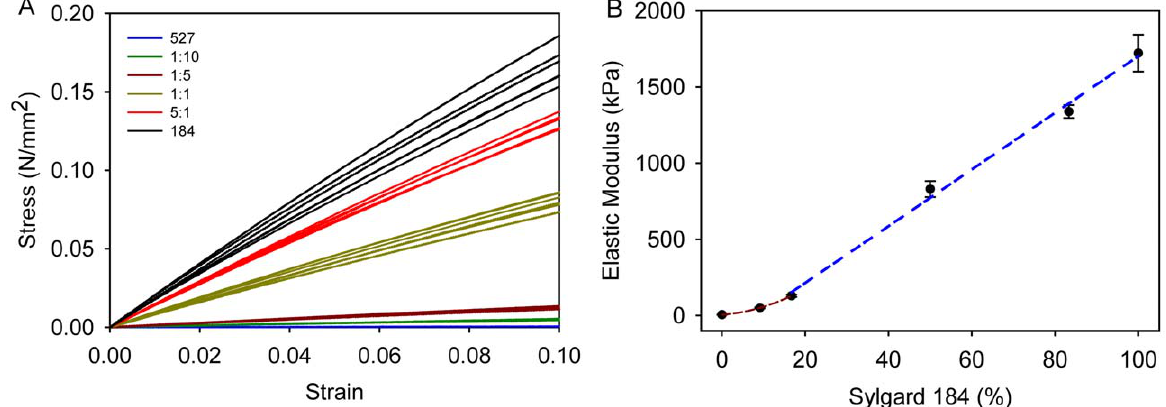
Figure 1. PDMS formulations span a wide range of mechanical properties from soft gels to stiff elastomers. (A) Stress strain curves for the six different PDMS formulations show that the curves for each type (n=6) are clustered and separated from the curves of the other formulations. Over a 10% strain all formulations are linearly elastic. (B) Elastic modulus of the six different PDMS formulations as a function of weight percent Sylgard 184. The elastic modulus of each formulation is significantly different from the other PDMS formulations (One-way ANOVA, p , 0.05). The curves predict that PDMS formulations can be fabricated with elastic moduli anywhere in the range from 5 kPa to 1.72 MPa by fine tuning the percentage of Sylgard 184 mixed in with the Sylgard 527. We have separated the data into two regimes, a non-linear regime for low percentages of Sylgard 184 (red curve) and a linear regime for larger percentages of Sylgard 184 (blue curve). The equation for the red curve is y=0.3236x2 + 2.0606x + 5 (R 2 =1). The equation for the blue curve is y=18.591x–156.87 (R 2 =0.995). Data represented as mean 6 standard deviation.